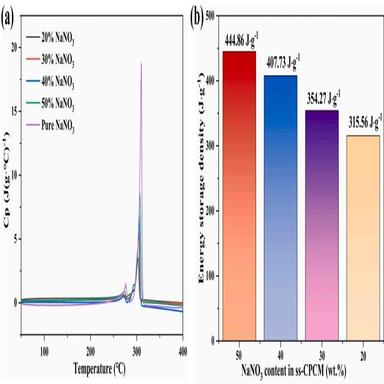
(a) Specific heat capacity as a function of temperature and (b) energy storage density of ss-CPCM as a function of the mass fraction of NaNO3.